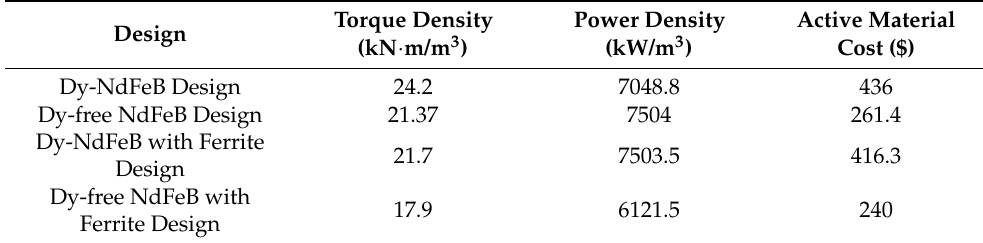
Table 13. Torque capabilities and cost